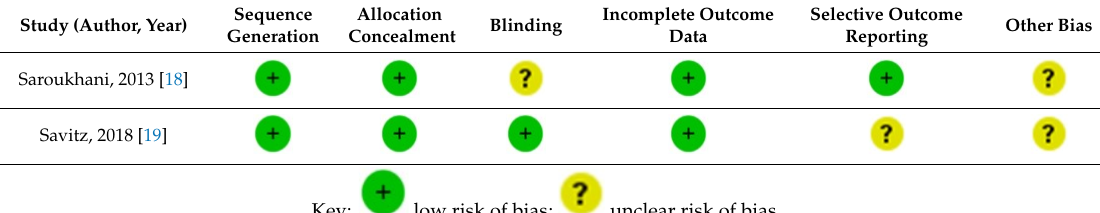
unclear risk of bias.